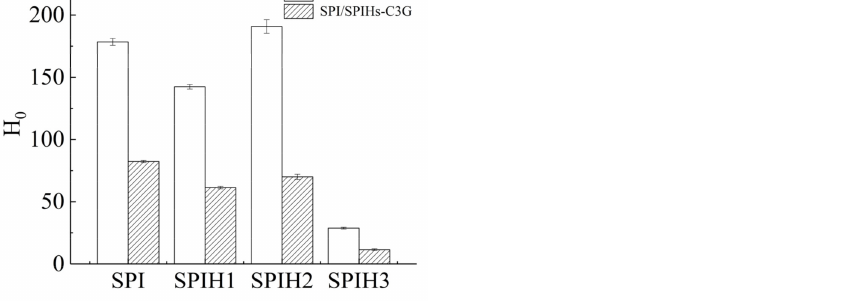
Figure 4. Surface hydrophobicity (H 0 ) of SPI and SPIHs with or without C3G. The mass concentration ratio of SPI/SPIHs and C3G was